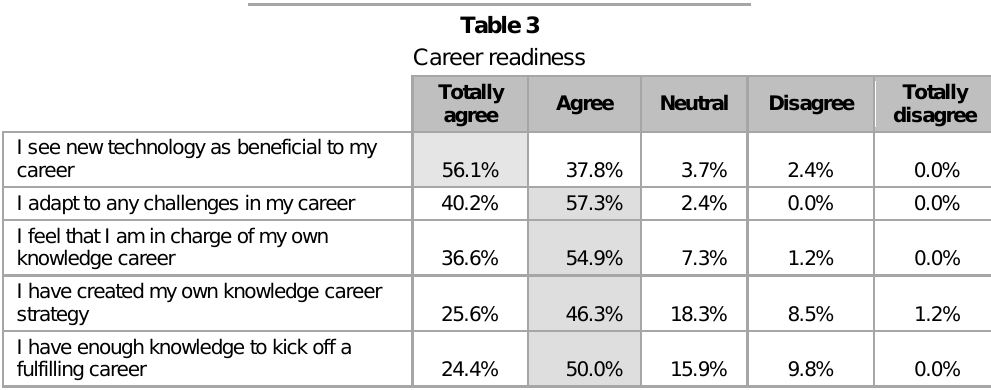
Figure 2 indicates that challenging work assignments, monetary rewards and